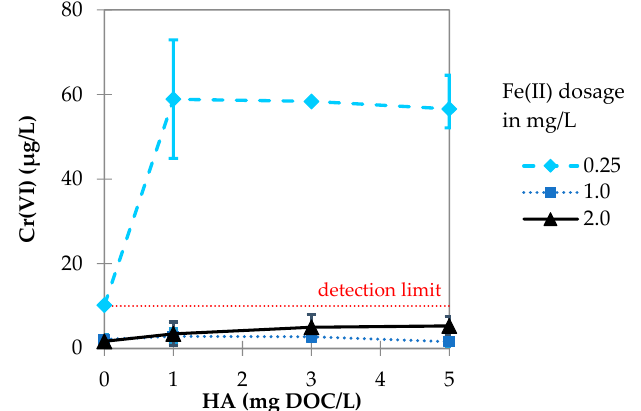
Figure 4. Cr(VI) residual concentrations after 60 min of slow stirring, as a function of the presence of HAs (concentrations: 0, 1, 3, 5 mg DOC/L) at pH 7 and for Fe(II) dosages 0.25, 1, and 2 mg/L. Mean values with vertical bars indicate the range. The results were obtained with the application of both set-ups A and B.